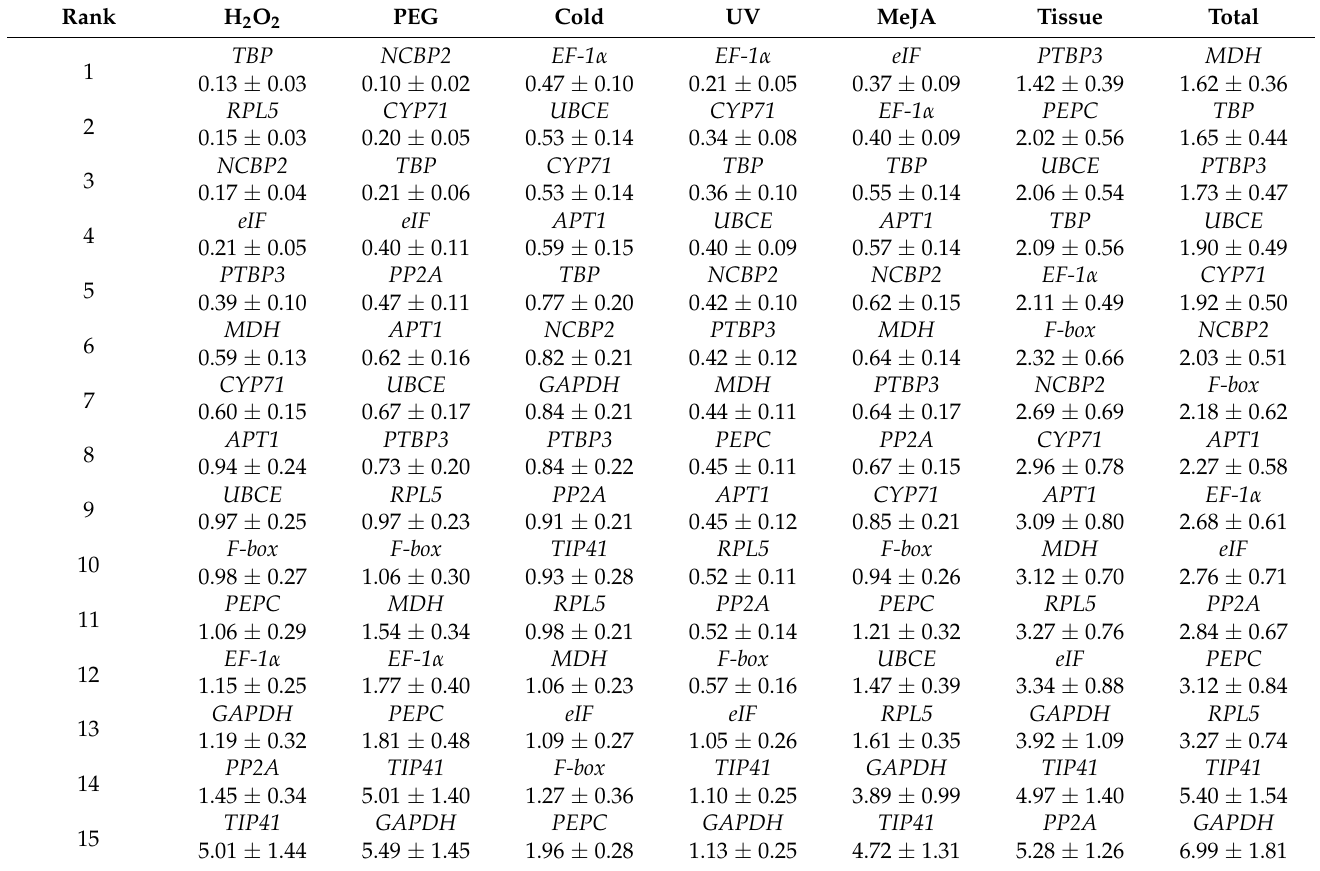
Table 3. Expression stability values (CV ± SD) of internal reference genes calculated by